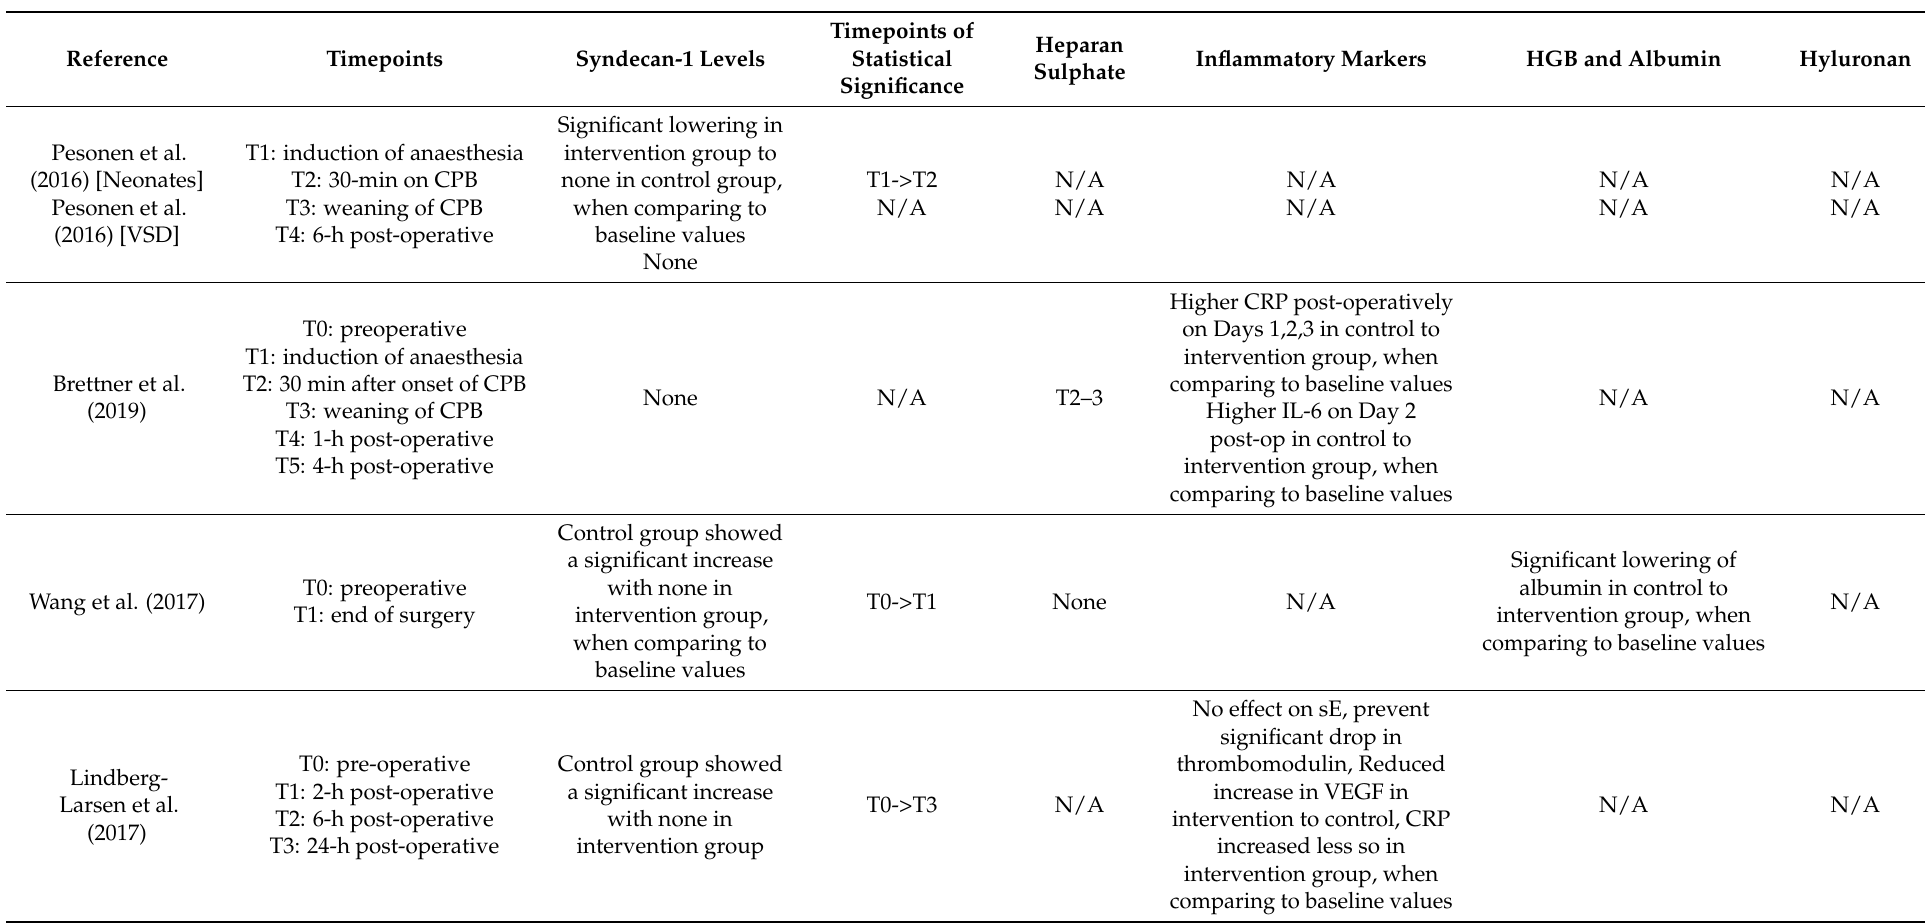
Table 2. Outcome on EG